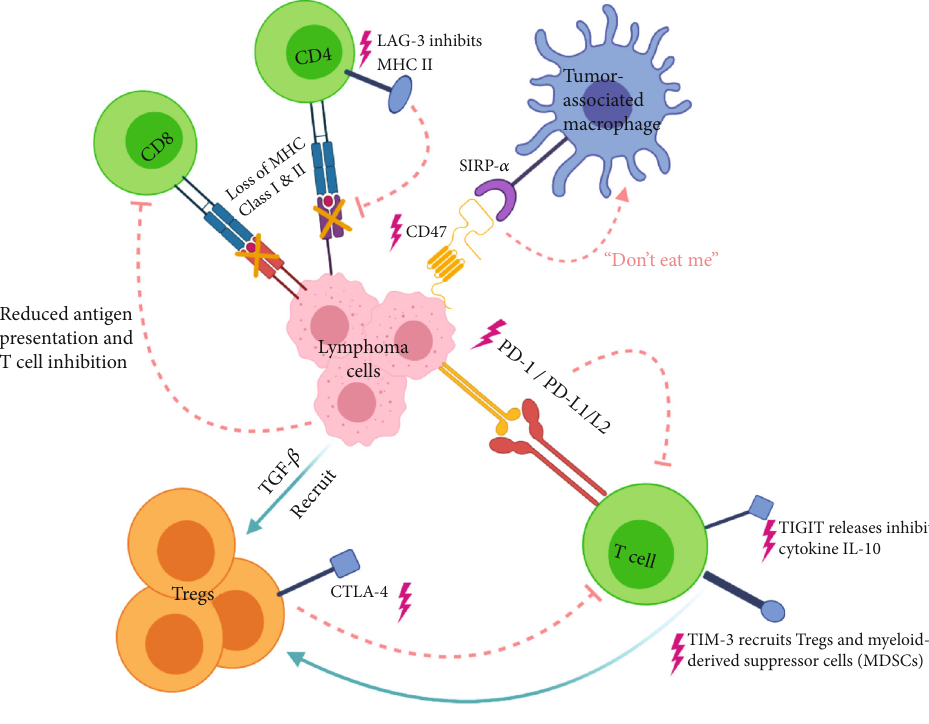
Figure 1: Mechanisms of immune escape by lymphoma (Figure 1). The TME is complex and heterogenous and com- prises of tumor cells, immune cells, stromal cells, blood ves- sels, and a variety of associated tissue cells. Immune cells present in the tumor include components of the innate (mac- rophages, dendritic cells, etc.) and adaptive immune system (B and T cells). T cell activation, which is the fi rst step in mounting an e ff ective immune response, occurs when anti- gen presenting cells (APCs) such as macrophages and den- dritic cells present foreign antigens to host T cells.